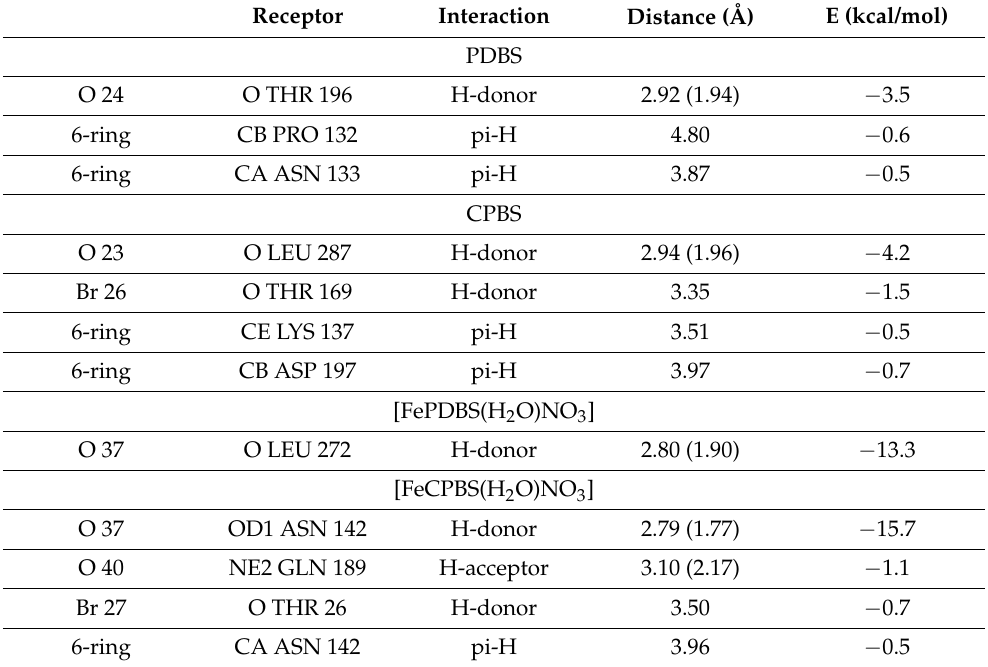
Table 9. The analysis of interaction data docking of PDBS, CPBS, [FePDBS (H 2 O) NO 3 ], and [FeCPBS(H 2 O) NO 3 ] with the active sites of the receptor of COVID-19 main protease viral pro- tein (PDB ID: 6lu7). Receptor